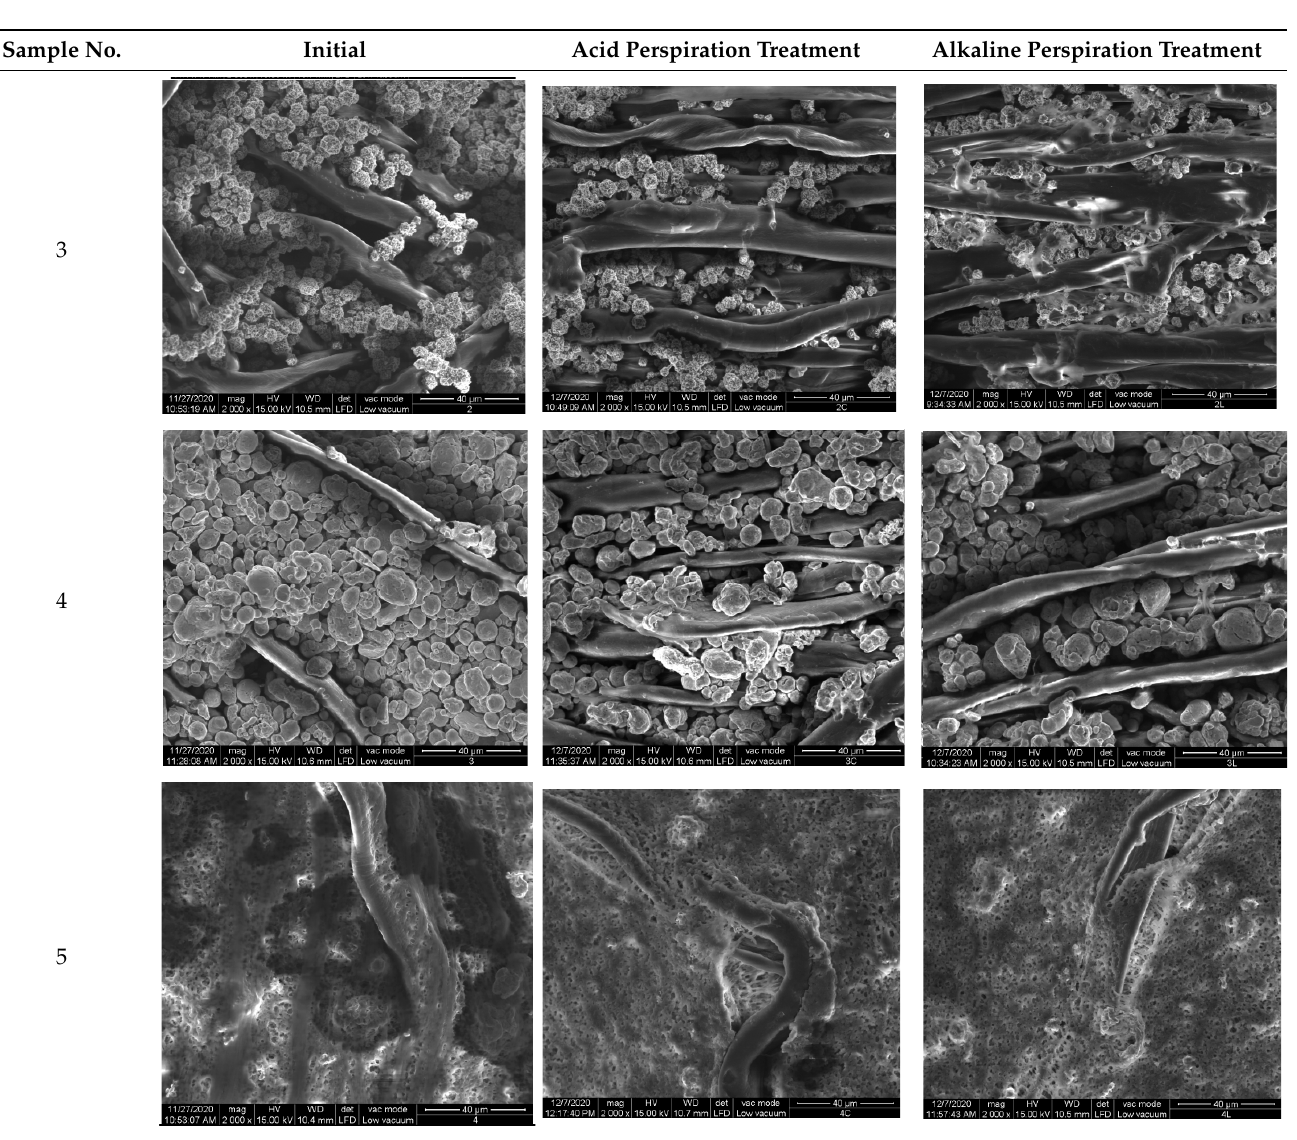
Table 3 shows the morphology of the textile surface untreated (sample 1) and coated with conductive paste-based graphene (sample 2), Ni (sample 3), Cu 1 (sample 4) and Cu 2 (sample 5). From the surface morphology of sample 4, in comparison with sample 5, it can be observed that the Cu 1 particles (14–25 µ m) have a homogeneous distribution on the textile surface. In the case of sample 3 based on Ni microparticles, a tendency of microparticles to agglomerate and to form clusters of microparticles can be observed. In addition, samples 2 (based on graphene) and 5 (based on Cu2 microparticles having dimensions <75 µ m) present a non-homogeneous distribution of the particles. In the case of samples 2, 3, 4 and 5 (Table 3), it can be observed that the aggregations of the microparticles are reduced after alkaline and acid perspiration treatments. This is because the PVA, PEG, and PVP are hydrophilic polymers, and PVDF dissolved in the organic solvent DMF becomes hydrophilic. Consequently, the sample surface becomes hydrophilic after coating through thin film deposition using screen printing the conductive paste on the textile surface. This explains that some metal microparticles may migrate in the water-based alkaline/acid perspiration solution after the immersion of the samples in acid/alkaline perspiration for 10 min. In addition, we observed that, after the